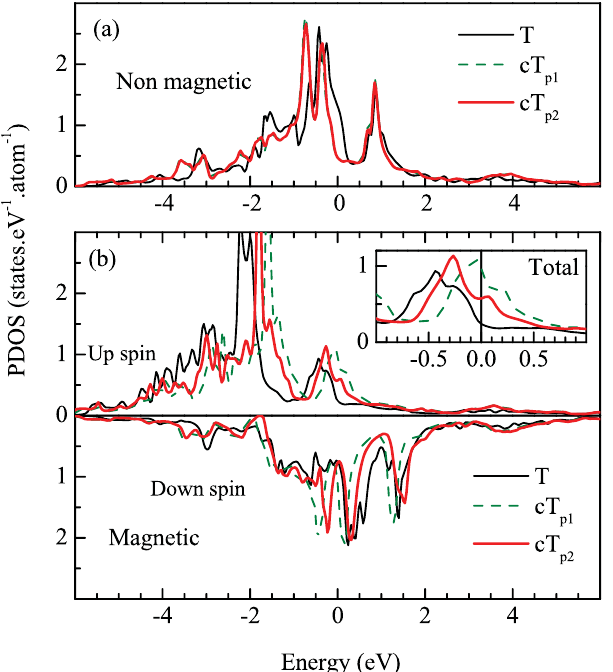
Figure 7. Fe 3 d partial density of states in tetragonal (T; thin solid line) and collapsed tetragonal structures at pressures, P = 0.47 GPa (cT p 1 ; dashed green line) and P = 0.63 GPa (cT p 2 ; thick solid line) in ( a ) non-magnetic and ( b ) magnetically ordered phases. The inset in ( b ) shows the total Fe 3 d PDOS at different structures. The definition of lines is kept similar to the main part of the